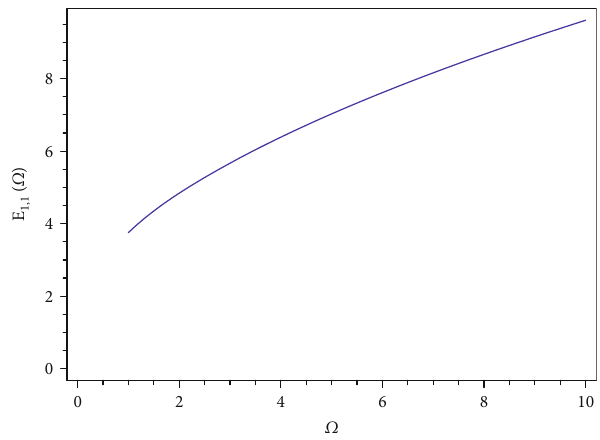
= η = M = 1 , α = 0 : 5 , ω = 0 : c L